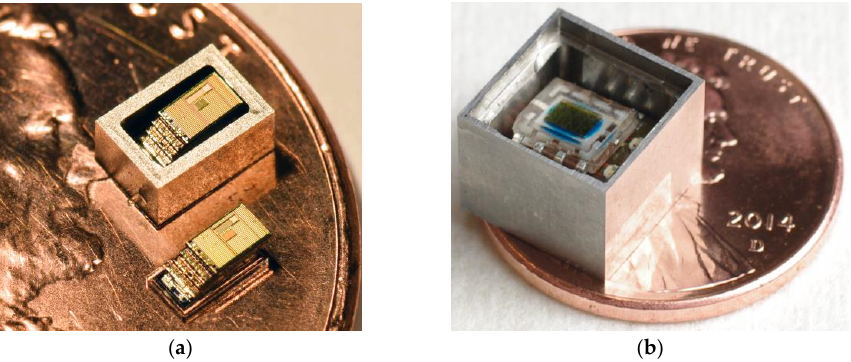
Figure 2. ( a ) Photo of the M 3 HT system stack ( bottom ) and inside a SS shell ( top ), on a US penny; ( b ) Photo of the ELM system in a SS shell before sealing with a sapphire lid, on a US penny.